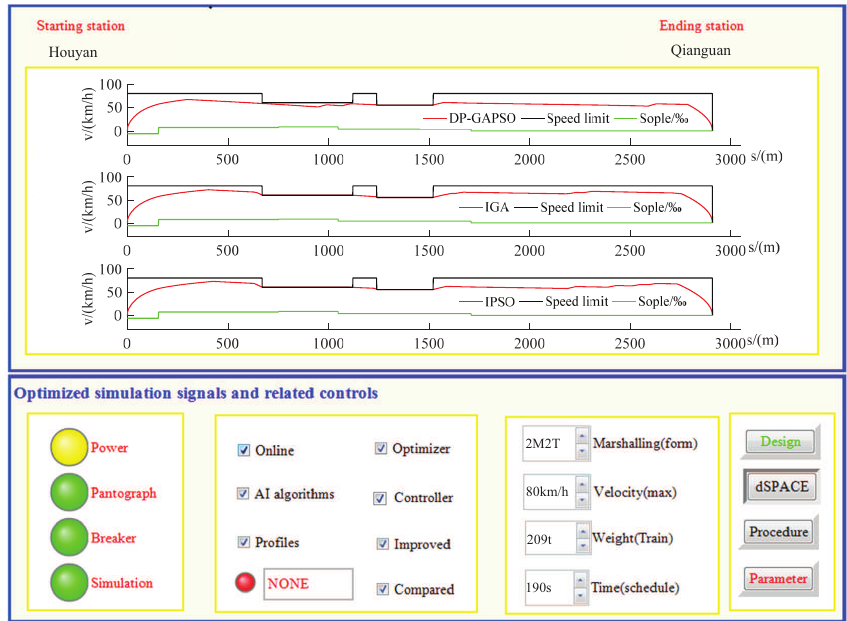
Figure 18. The speed distance curve of the train from Houyan to Qianguan.